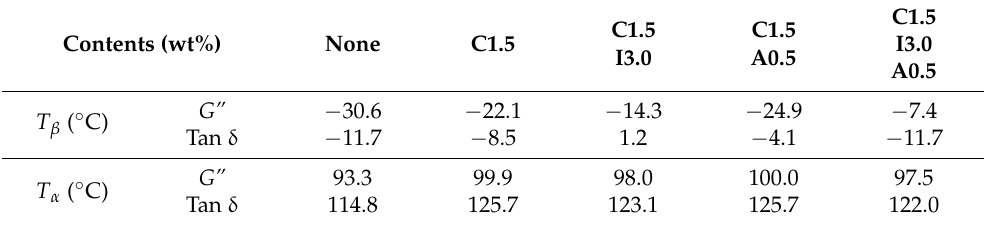
Table 6. Transition temperatures of POM, POM/C1.5, POM/C1.5/I3, POM/C1.5/A0.5, and POM/C1.5/I3/A0.5 nanocomposites with different additive concentrations, based on DMA